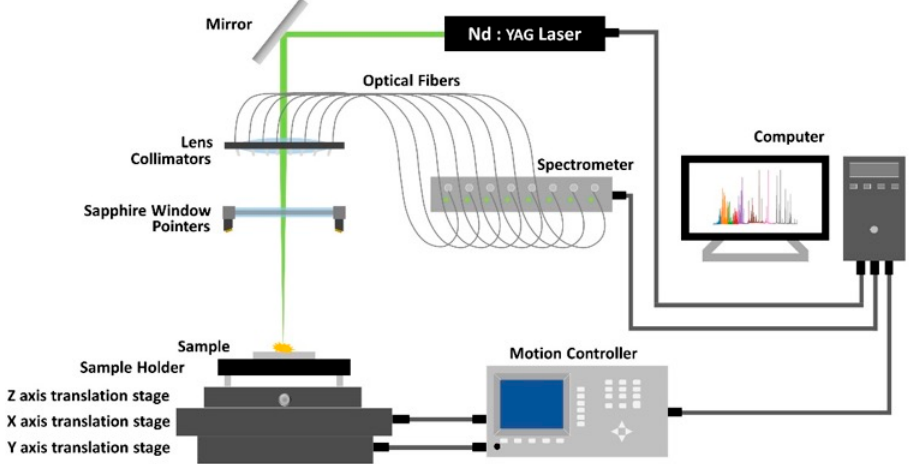
Figure 4. LIBS experimental setup.